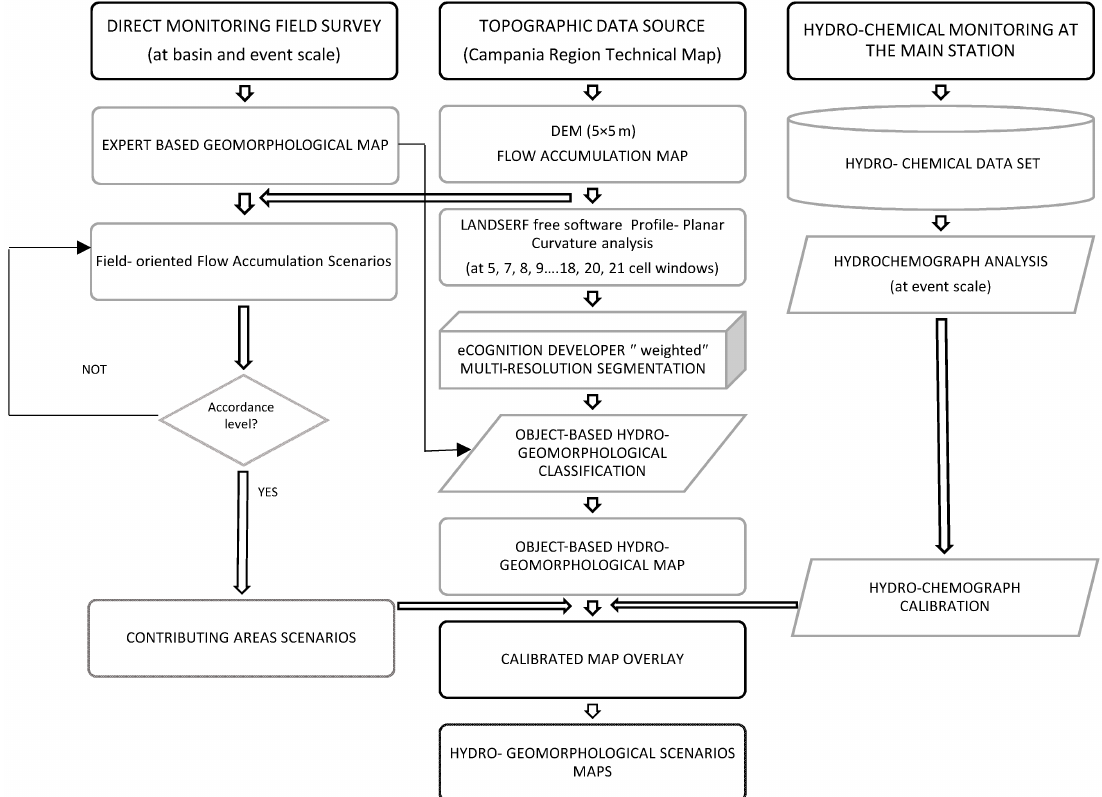
Figure 3. Flow chart procedure for identifying contributing